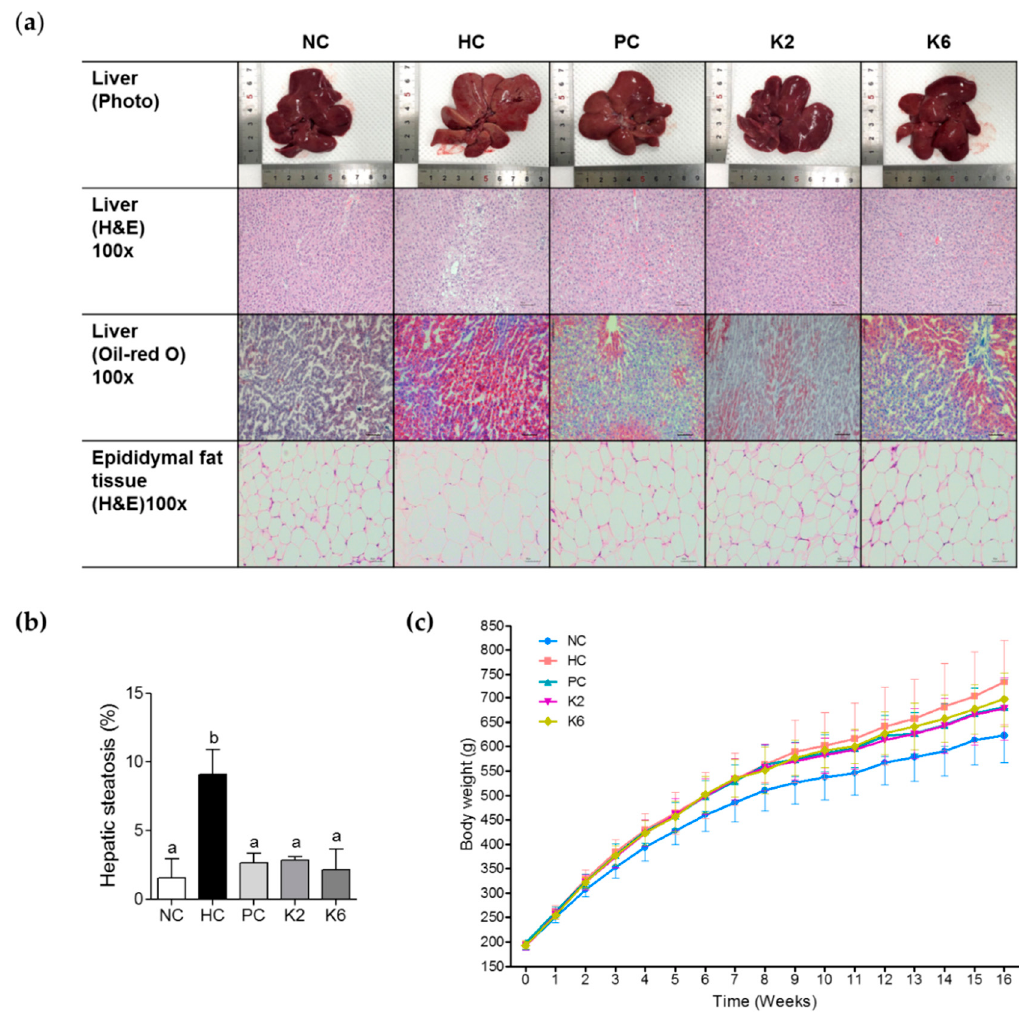
Figure 2. E ff ects of K2 and K6 on hepatic steatosis and body weight in rats with HF / HF-induced non-alcoholic fatty liver disease (NAFLD). ( a ) Histochemical and ( b ) morphometric analysis of liver samples and ( c ) body weight changes in rats on HF / HF diet with or without K2 and K6. NC, normal diet control; HC, HF / HF diet control; PC, HF / HF diet with silymarin; K2, HF / HF diet with ATG-K2; K6,